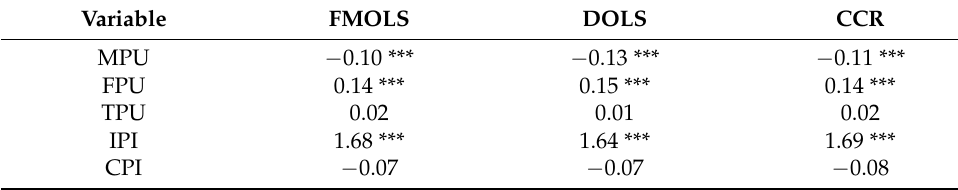
Table 6. FMOLS, DOLS, and Canonical Cointegrating Regression